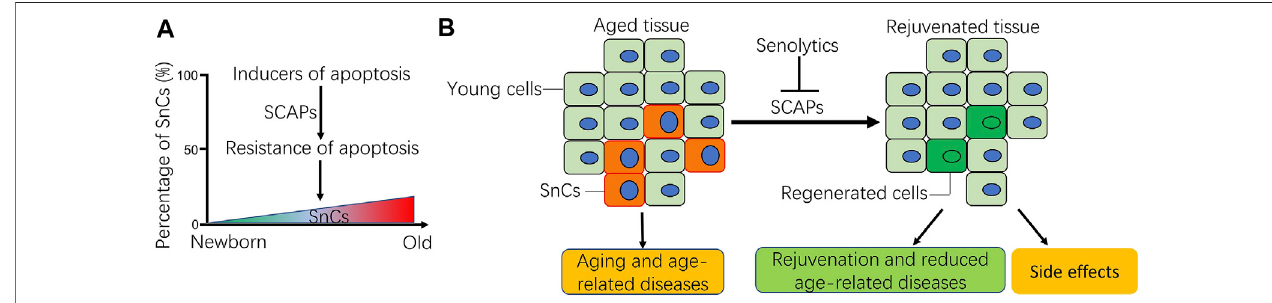
FIGURE1| Schematicofapoptoticresistanceofsenescentcells(SnCs)inagingandage-relateddiseases. (A) Duringtheagingprocess,aging-relateddisruptions in systemic and inter-cell signaling, together with cell-autonomous damage and mitochondrial malfunction result in either increased or decreased cell apoptosis depending on cellular context (Tower, 2015). As for SnCs, their percentage usually increases in tissues with age as they acquire resistance to apoptotic stimuli via the SnC anti-apoptotic pathways (SCAPs). (B) Accumulation of SnCs in tissues contributes to aging and the occurrence of age-related diseases. Senolytics can selectivelycleartheSnCsbytargetingtheSCAPs,whichpromotetheregenerationofyoungcells,rejuvenateagedtissuesandreduceage-relateddiseases.Sometimes, senolytics can also cause side effects, more caution should be exercised for the systemic use of senolytics for health bene fi ts. Note: B was modi fi ed from our previous publication (Li et al., 2019a; Li et al.,